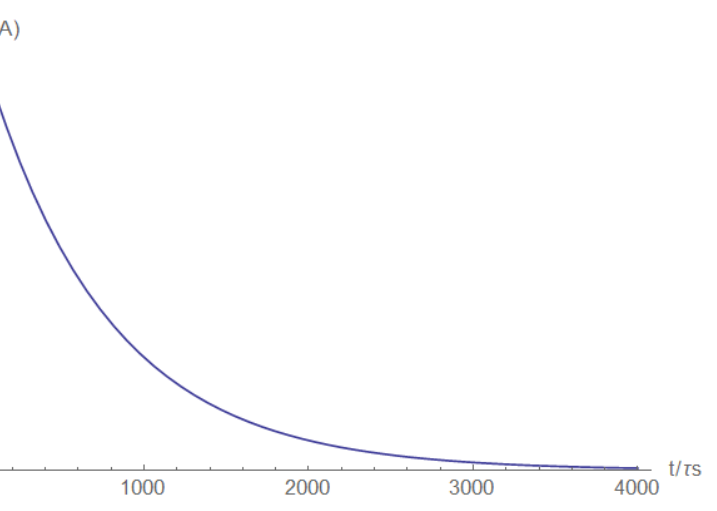
Figure A22. Load current (after some